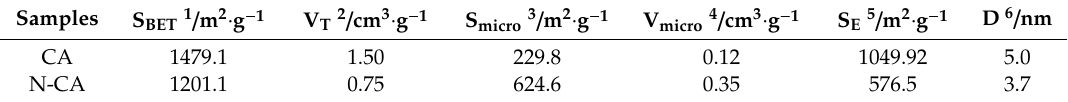
Figure 3. N 2 adsorption–desorption isotherms of ( a ) CA and ( d ) N-CA; pore size distributions curves of ( b ) CA and ( e ) N-CA; contact angle tests of ( c ) CA and ( d ) N-CA. Table 1. Textural parameters of CA and N-CA.